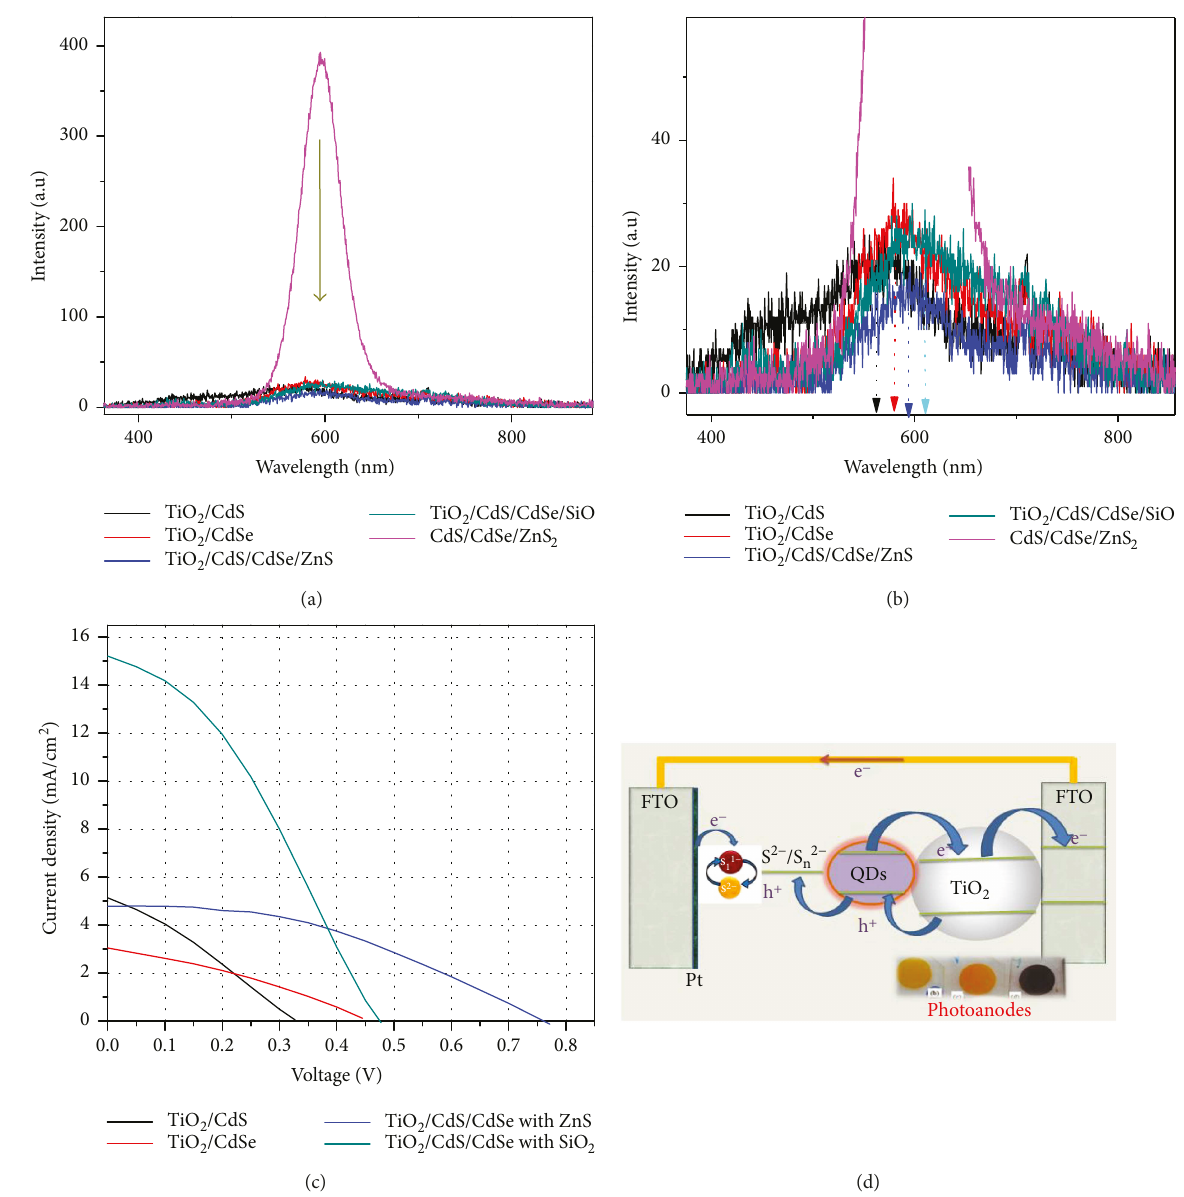
Figure 4: (a, b) Photoluminescence, (c) J - V curves of distrinct photoanodes, and (d) structure and energy levels alignment of the